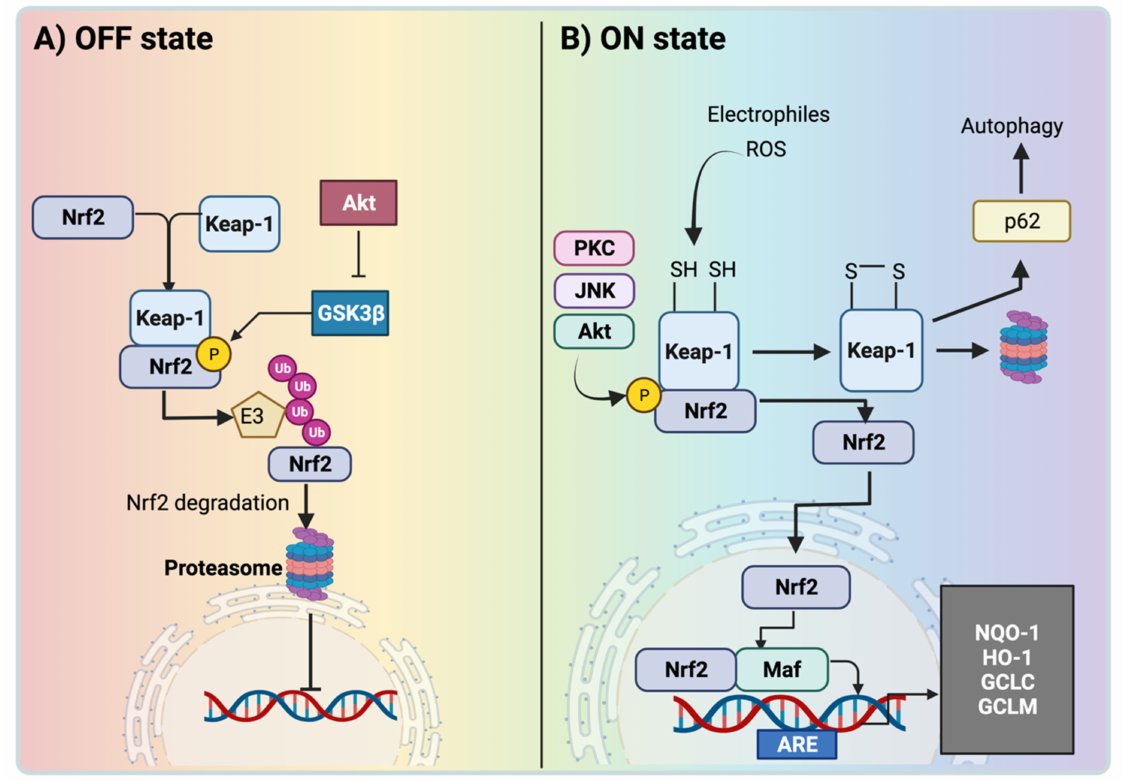
Figure 1. Nuclear factor erythroid 2-related factor 2. ( A ) In the OFF state, the nuclear factor erythroid 2-related factor 2 (Nrf2) is kept at a basal activity level by Kelch-like ECH-associated protein 1 (Keap1). In addition, the inhibition of Akt induces the upregulation of glycogen synthase kinase 3 beta (GSK3 β ), promoting the phosphorylation and degradation of Nrf2. Both mechanisms lead to Nrf2 degradation via the proteasome. ( B ) In the ON state, electrophiles and ROS modify the cysteine residues of Keap1, promoting its degradation via proteasome or via sequestosome (p62). The latter induces the nuclear translocation of Nrf2 to interact with the musculoaponeurotic fibrosarcoma (maf) proteins and bind to antioxidant response elements (AREs), triggering the expression of NADPH quinone oxidoreductase (NQO1), heme oxygenase-1 (HO-1), glutamate-cysteine ligase catalytic (GCLC), and glutamate-cysteine ligase modifier (GCLM). The figure was created using